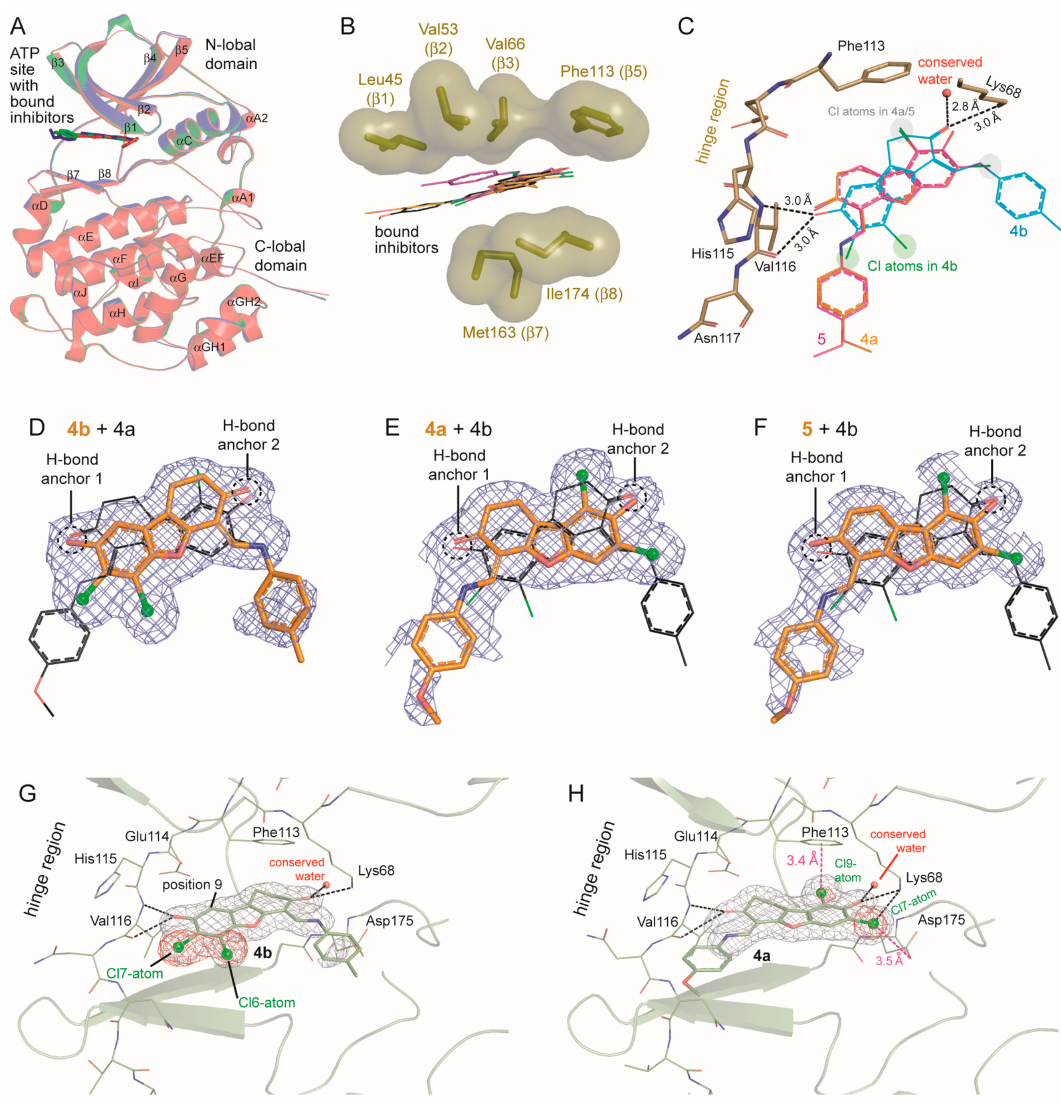
Figure 7. Human CK2 α crystal structures in complex with 4b , 4a , and 5 . ( A ) Global overview of the three superimposed structures (red: 4b complex; green: 4a complex; blue: 5 complex). ( B ) Hydrophobic sandwiching of the dibenzofuran framework by non-polar side chains of the N-lobal strands β 1, β 2, β 3 and β 5 from one side and of the C-lobal strands β 7 and β 8 from the other. ( C ) Each of the inhibitors forms two pairs of hydrogen bonds (drawn in detail for 4b ) with the enzyme. ( D – F ) Section of the three inhibitors covered by the final electron densities (cutoff level 0.5 σ ) after superimposition of the harboring protein matrices. To facilitate a comparison of the orientations either 4a ( D ) or 4b ( E , F ) is additionally drawn with black C-atoms. The hydroxy/oxo groups that form hydrogen bonds and that are positionally preserved are indicated by dashed circles. ( G , H ) Experimental verification of the different orientations of 4b and 4a using the diffraction data sets at 2 Å wavelength (Table 4) at which the anomalous scattering of chlorine is enhanced. In both pictures the respective ligand is covered by its final electron density (grey mesh; cutoff 1 σ ). The positions of the chlorine atoms are indicated by red ( G ) anomalous difference Fourier density (cutoff level 4 σ